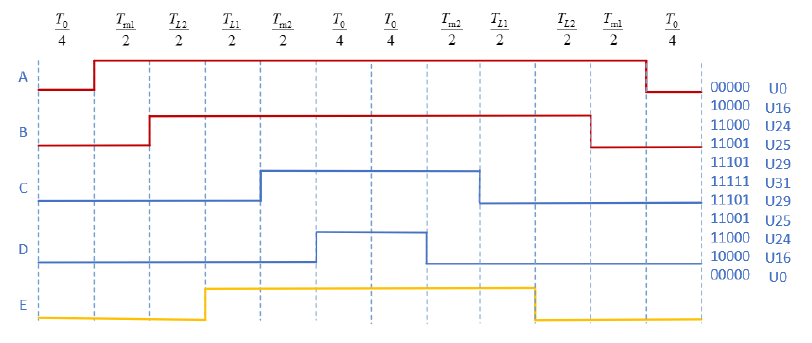
Figure 5. Modulation waveforms in the first sector.